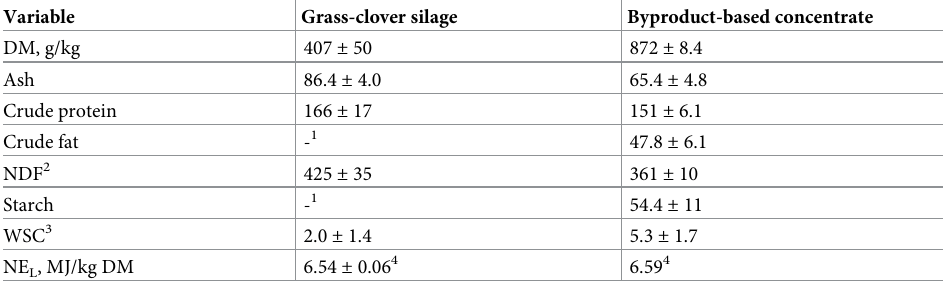
Table 1. Chemical composition (mean ± SD) of experimental feeds (g/kg DM, unless otherwise stated). Where standard deviation is reported, the number of samples used for analyses of chemical composition was n = 31 for silage and n = 32 for concentrates (except fat content, where n =